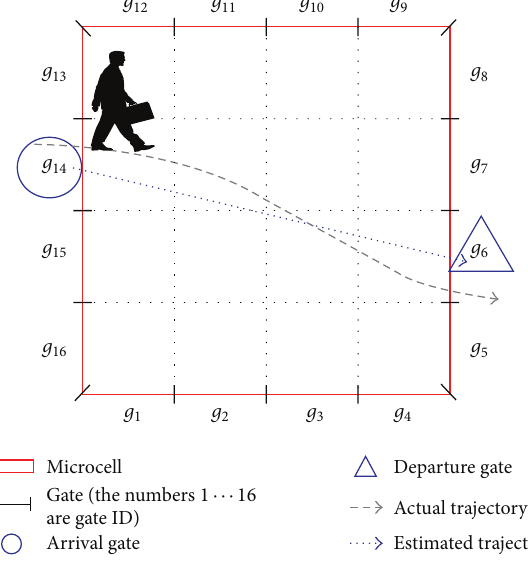
Figure 6: Relationship between a microcell and gates ( 𝑛 = 16